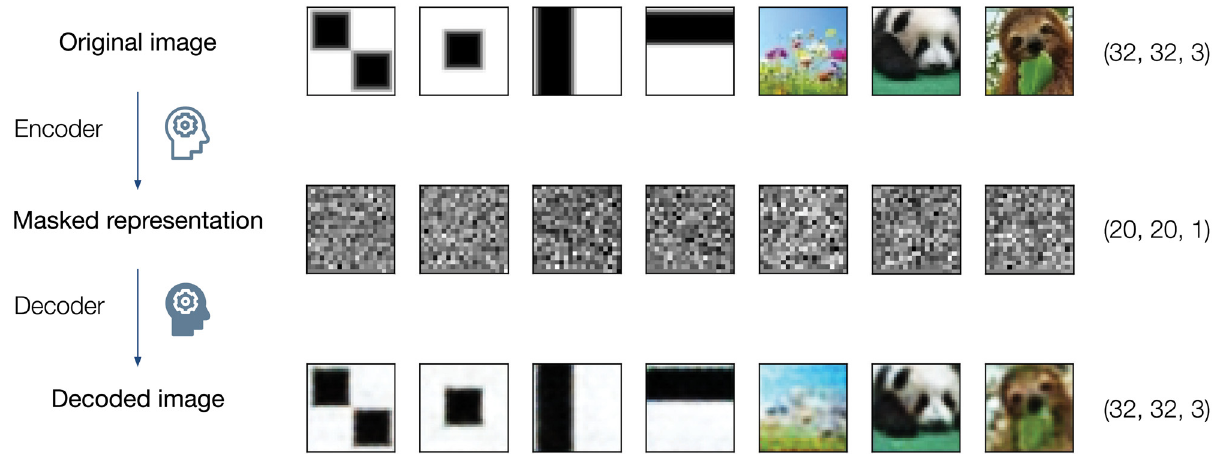
Fig 1. Examples of the masked representation of the input images. Top row represents original images used for the test. Middle row shows Gaussian part of the latent space, reshaped to the square image of the size 20x20. Bottom row represents the output from the decoder.